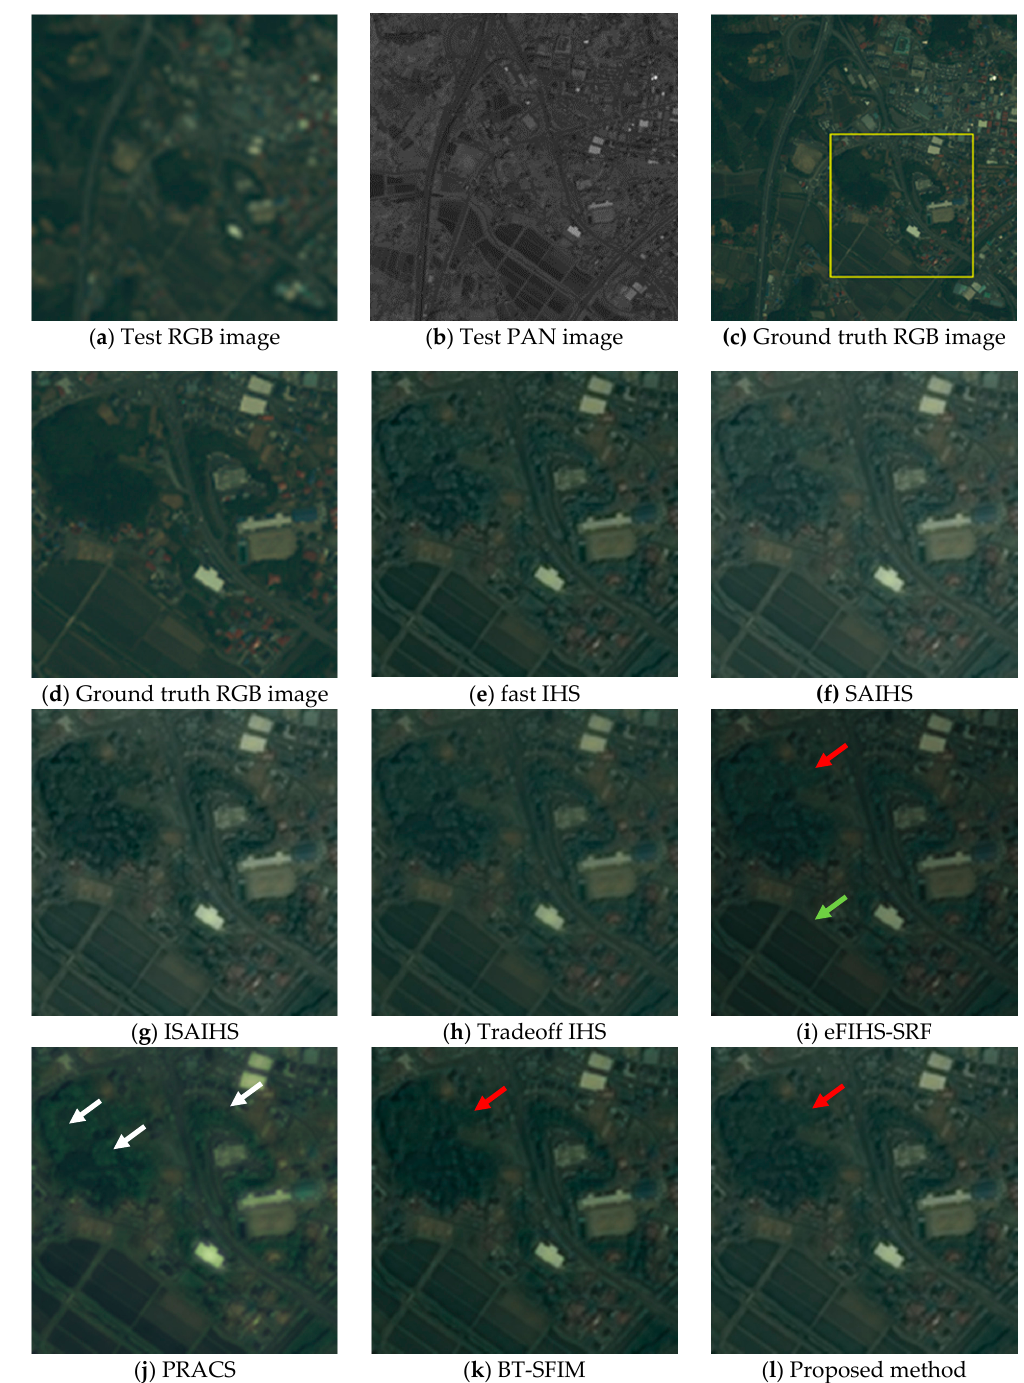
Figure 4. Visual comparison of test Nihonmatsu images: ( a ) Test red–green–blue (RGB) image; ( b ) Test PAN image; ( c ) Ground truth RGB image (i.e., Original RGB image); ( d ) Ground truth RGB image of the yellow box area in (c); ( e–l ) PS images generated by various methods corresponding to the area of (d); The red arrow indicates where the forest colors are well reproduced. The green arrow indicates where the color of the rice field is dark. White arrows indicate where the green tones are light.